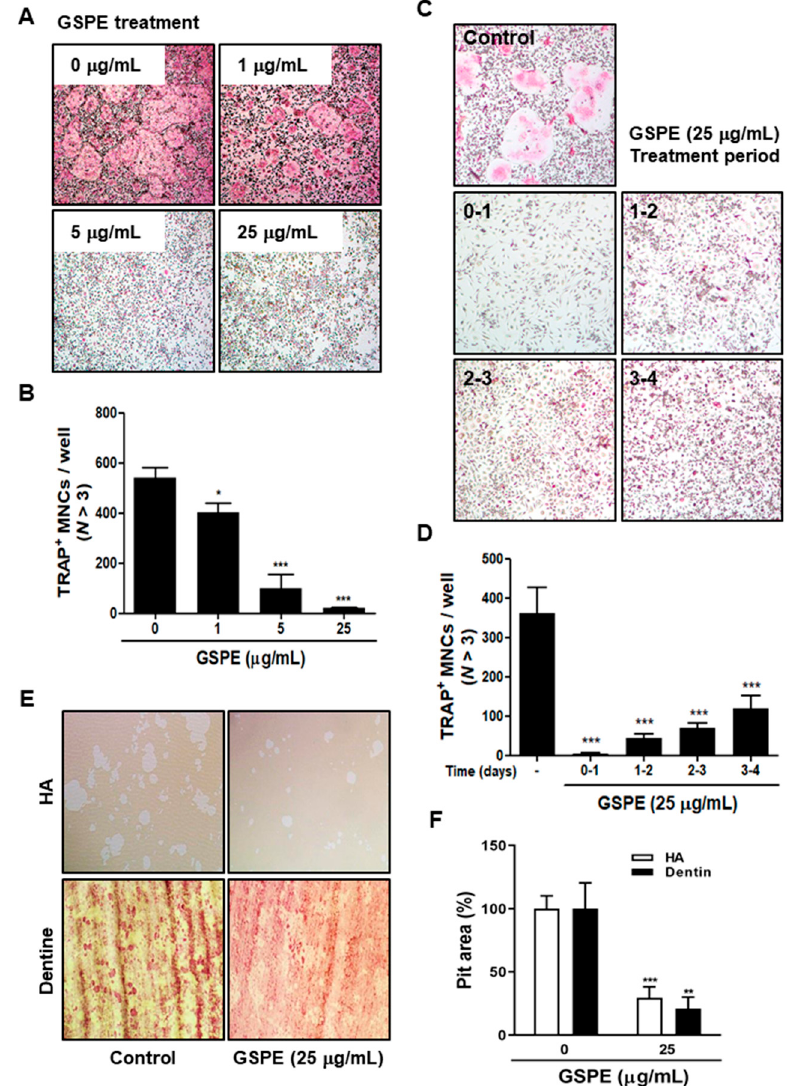
Figure 2. GSPE represses RANK-induced osteoclast differentiation and bone resorption activity. ( A ) BMMs were cultured for 4 days in the presence of 30 ng / mL M-CSF and 100 ng / mL RANKL in DW or GSPE. Cells were fixed with 3.7% formalin, permeabilized with 0.1% Triton X-100, and stained with TRAP solution. ( B ) TRAP-positive multinucleated cells were counted as osteoclasts. ( C ) BMMs were cultured as in A, and in addition treated with 25 µ g / mL GSPE on the indicated days. After culturing, cells were stained and ( D ) the number of TRAP-positive MNCs was counted. ( E ) Mature osteoclasts were seeded on HA-coated plates or dentin slices and treated for 12 or 48 h with 25 µ g / mL GSPE. Attached cells on the plates were removed and photographed under a light microscope. ( F ) Pit areas were quantified using ImageJ. * p < 0.05; ** p < 0.01; *** p < 0.001 versus control. Abbreviations: GSPE, grape seed proanthocyanidin extract; RANKL, receptor activator of nuclear factor kappa-B ligand; BMMs, bone marrow macrophages; M-CSF, macrophage colony-stimulating factor; DW, distilled water; TRAP, tartrate-resistant acid phosphatase; MNCs, multinucleated cells; HA,